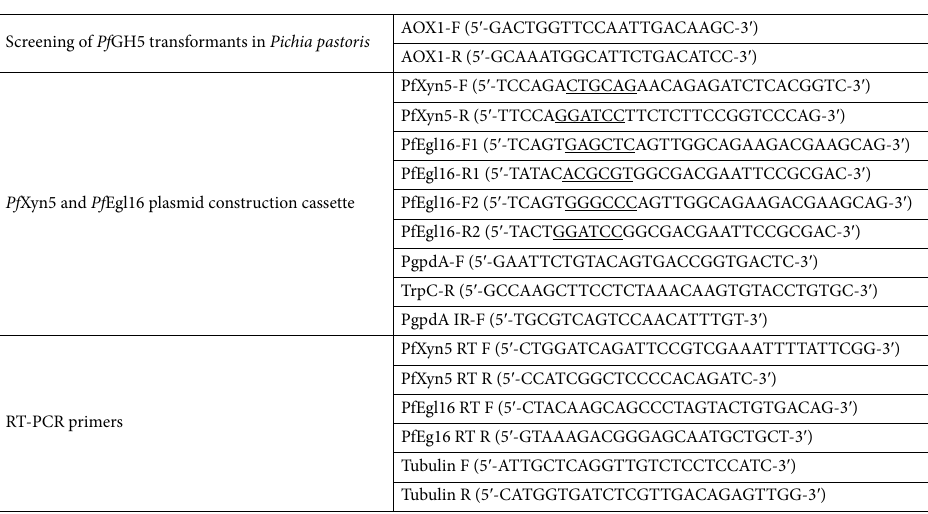
Screening of Pf GH5 transformants in Pichia